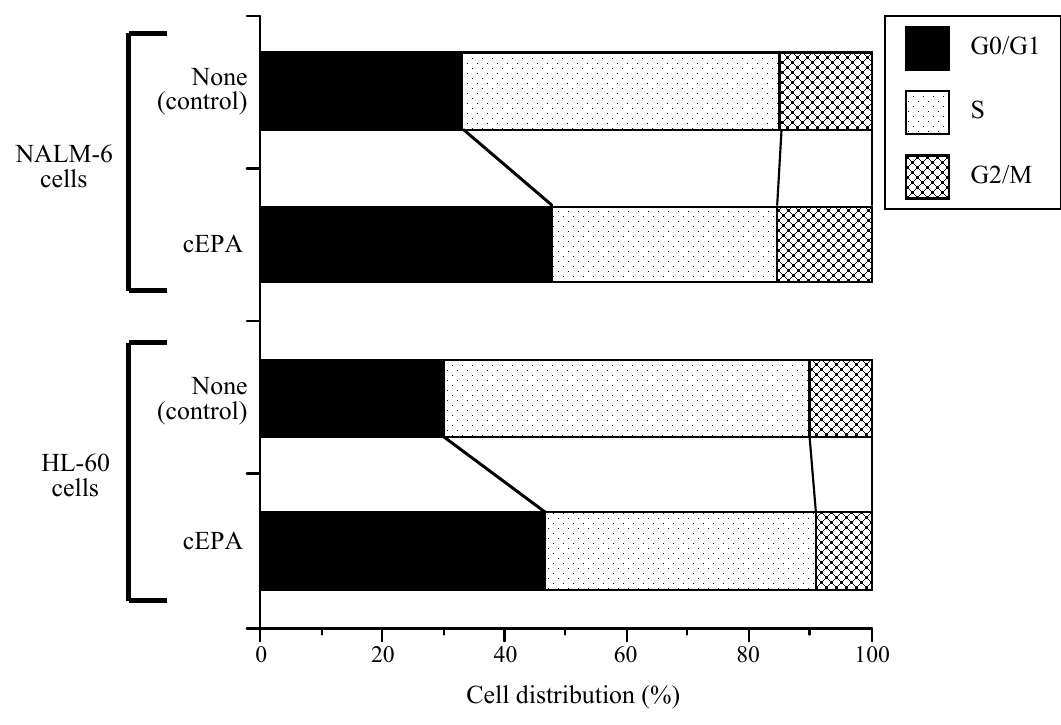
Figure 5. The effect of cEPA on the cell cycle. Flow cytometric analysis of NALM-6 cells and HL-60 values of cEPA (i.e., 37.5 and 12.5 μ M, cells were incubated without (control) or with the LD 50 respectively) for 24 hours. Cell cycle distribution was calculated as the percentage of cells in the G0/G1, S and G2/M phase. All experiments were performed three